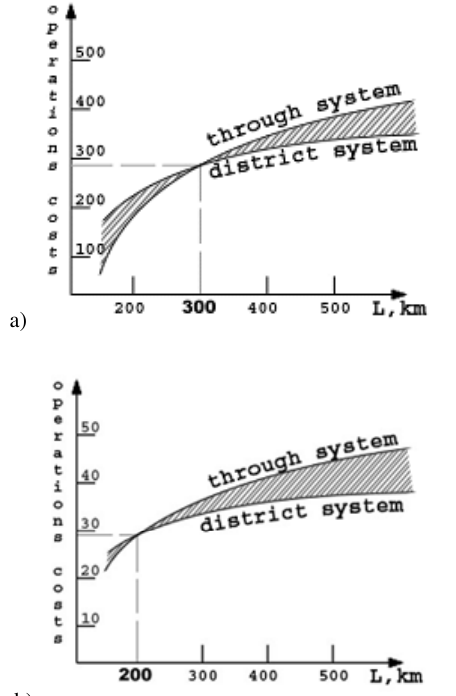
Fig 2 . Comparative costs of “through” and “district” traffic systems depending on volume of transportation: a – operational costs (thousands of rubles), 100 tons/day; b – operational costs (millions of rubles), 1000